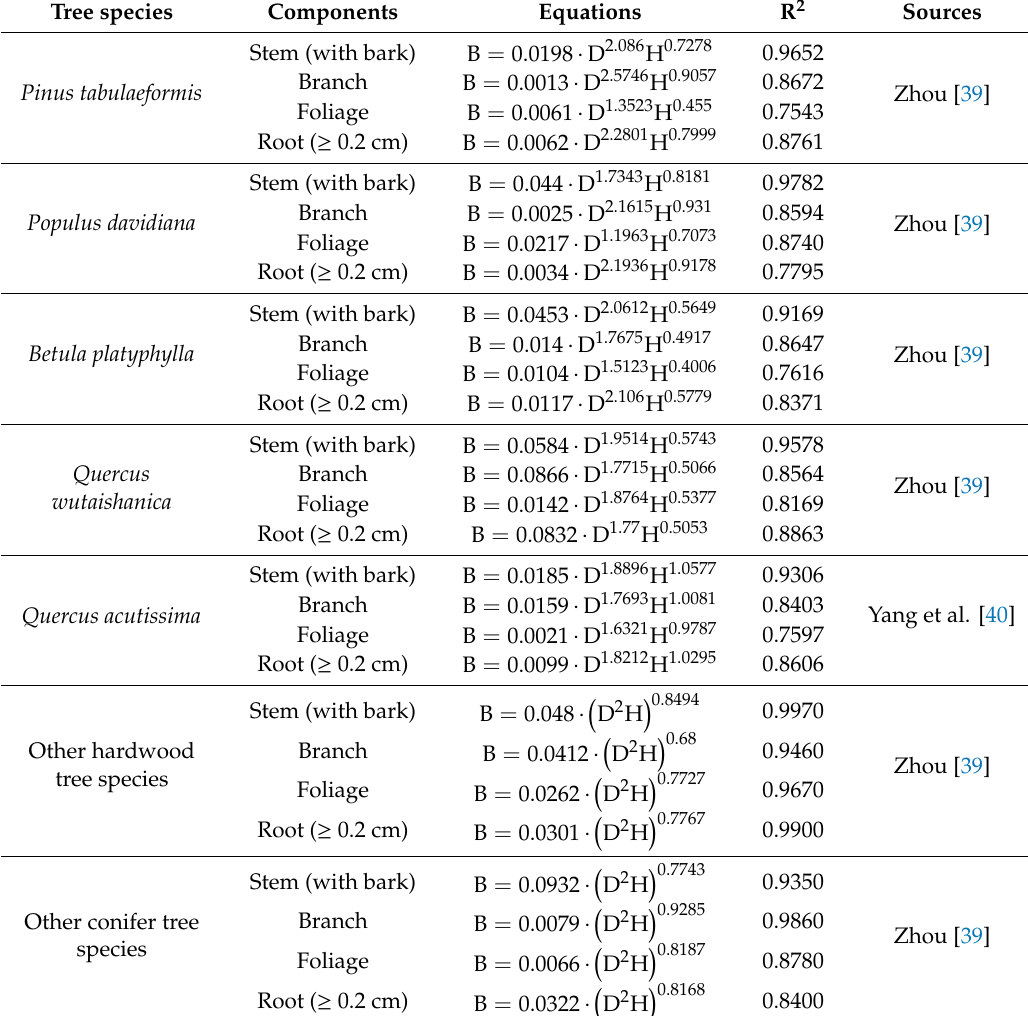
Table 2. Species-specific allometric equations used to quantify the biomass of the tree